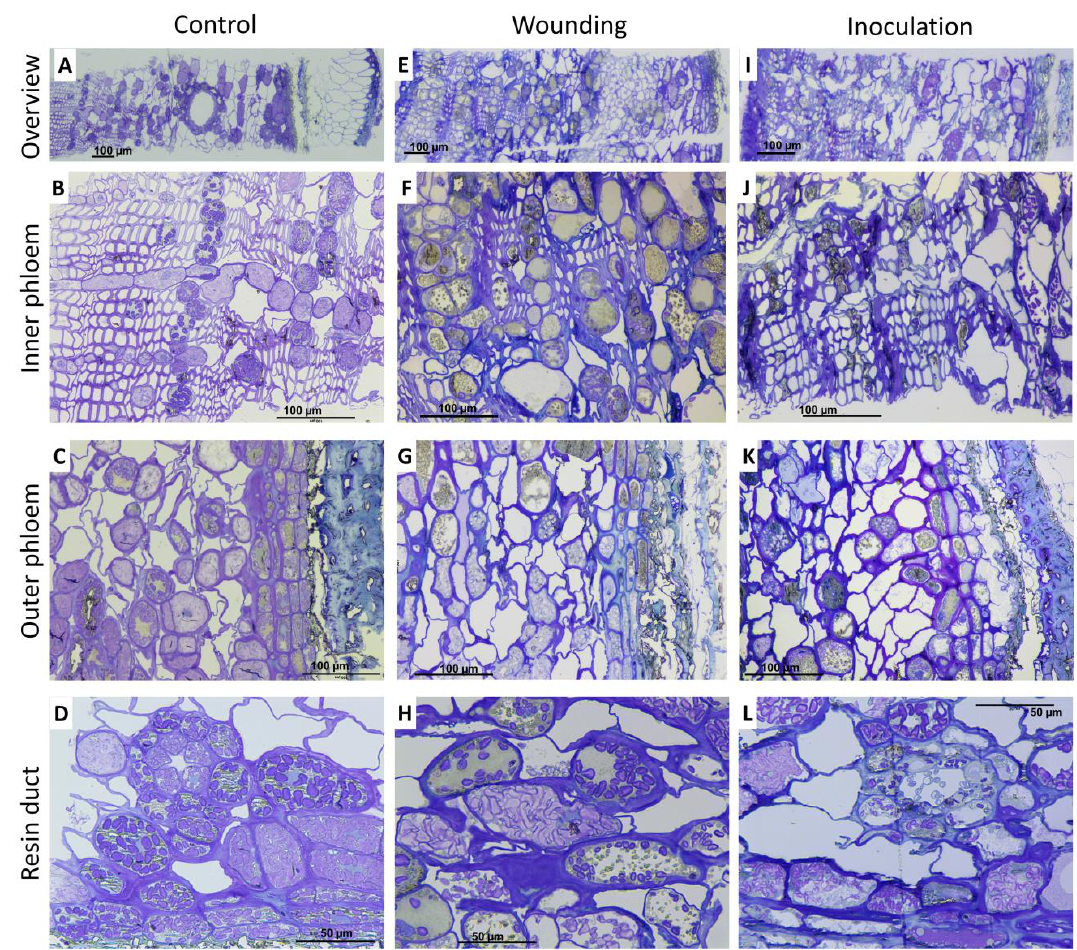
Figure 6. Bright field microscopy images of transverse surface of phloem in saplings of Norway spruce 23 days after inoculation: control saplings ( A – D ), wounded saplings ( E – H ), and fungus-inoculated saplings ( I – L ). The uppermost panels ( A,E,I ) show overview of phloem; panels B, F, and J show the tissues in innermost phloem (tangential rows of axial phloem parenchyma, sieve cells); the panels C, G, and K show the outermost phloem; and panels D, H, and L show the details of cellular properties. Scale bars on each figure.